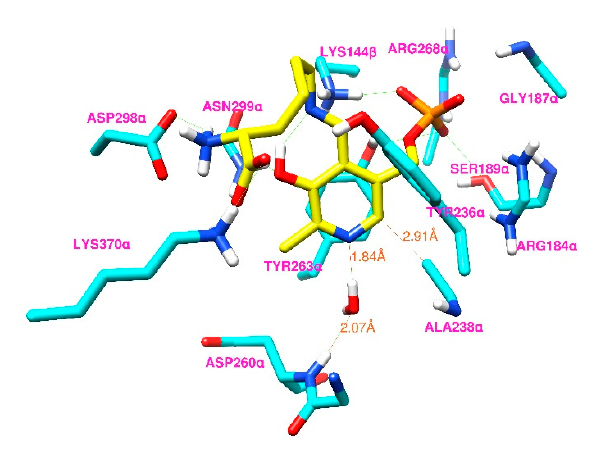
Figure 7. Stereo view of the active-site interactions of D-lysyl-PLP-H 2 O docked into the open state of the S238A variant of 5,6-LAM. Selected residues of 5,6-LAM (cyan) are shown in stick representation. D-lysyl-PLP (yellow) and water are also shown in stick representation.